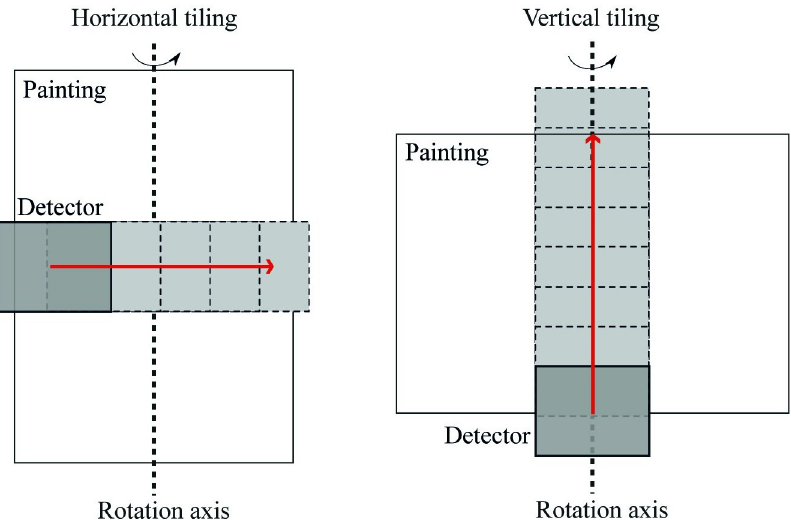
Fig 2. Possible orientations to scan the panel. Horizontal tiling (left): this setup requires fewer tiled scans, but the rotation axis lies outside the field of view of the detector for all tiles except the central one, resulting in parts of the painting to rotate in and out of the field-of-view. Vertical tiling (right): this setup requires more tiles, but the section of the painting we want to image stays within the detector field-of-view for all tiles during the rotation.